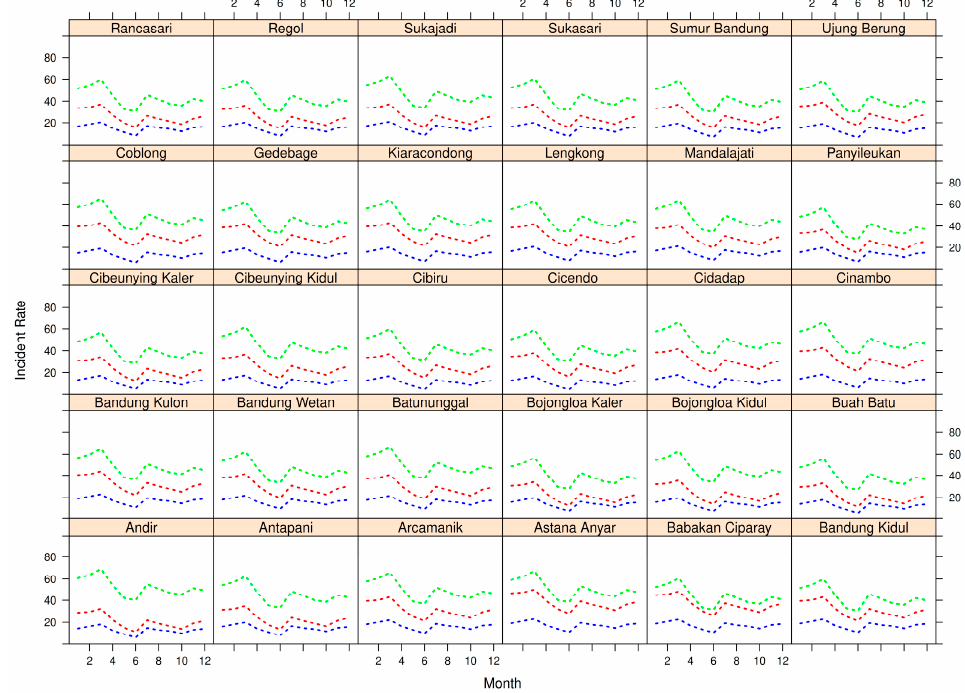
Figure 1. Quantile plots over months of incidence rate of dengue fever in Bandung city from 2017–2021 for three quantile levels (blue for 0.25, red for 0.50, and green for 0.75). As can be seen in Figure 1, there is variation in the distance between the quantile curves for each district. The largest gaps between quantiles 0.25 and 0.5 are found in Astana Anyar and Ciparay, and the largest gaps between quantiles 0.5 and 0.75 are found in Andir. The smallest distance between quantiles 0.25 and 0.50 was observed in Andir, and the smallest distance between quantiles 0.50 and 0.75 was found in Babakan Ciparay district. Figure 1 shows that the 0.25 quantile curve has a similar trend in all districts and is less than 20, while the 0.50 quantile curve varies from district to district. On the other hand, at the quantile 0.75 we see much larger difference curves. Generally, quantile values are less than 80. The curves typically decrease through the middle of the year and then rise slightly to the end of the year. 3.3. Quantile Maps The results related to spatial locations are shown through a quantile map. The map shows quantile values based on color grading. Small quantile values are represented by the light color (yellow), and high quantile values are represented by the dark colors (dark green). The representative spatial maps of quantile URTI data of Bandung city are shown in Figure 2 for February, May, August and November. Each map presents three quantile levels. The left is the 0.25 quantile, the middle is the 0.50 quantile, and the right is the 0.75 quantile.